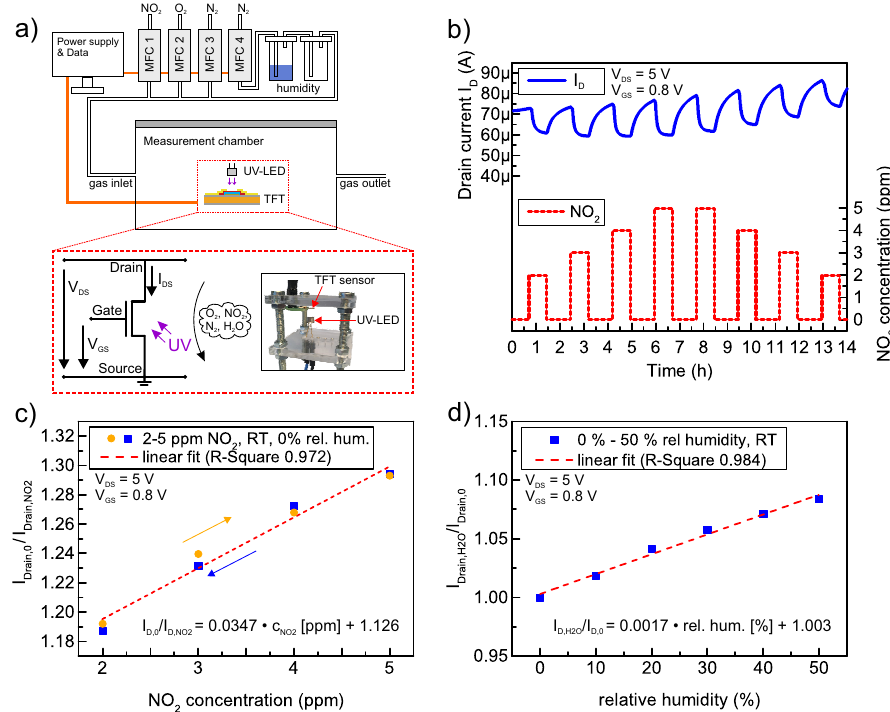
Figure 5. ( a ) schematic of the measurement setup. The desired gas mixture is prepared by four mass flow controllers (MFC 1-4), each connected to a different gas species. The relative humidity is changed by the ratio between dry (MFC 3) and wet (MFC 4) nitrogen. The TFT gas sensor, as well as the UV-light source are placed inside the measurement chamber (see photograph). The biasing and measurement scheme is presented in the inset; ( b ) I D raw signal to 2–5 ppm NO 2 with 20% background oxygen, 0% relative humidity at room temperature; ( c ) normalized sensor signal to 2–5 ppm NO 2 . The arrows indicate the sweep direction of the NO 2 concentration; ( d ) cross-sensitivity to humidity (20% oxygen, RT) as normalized sensor